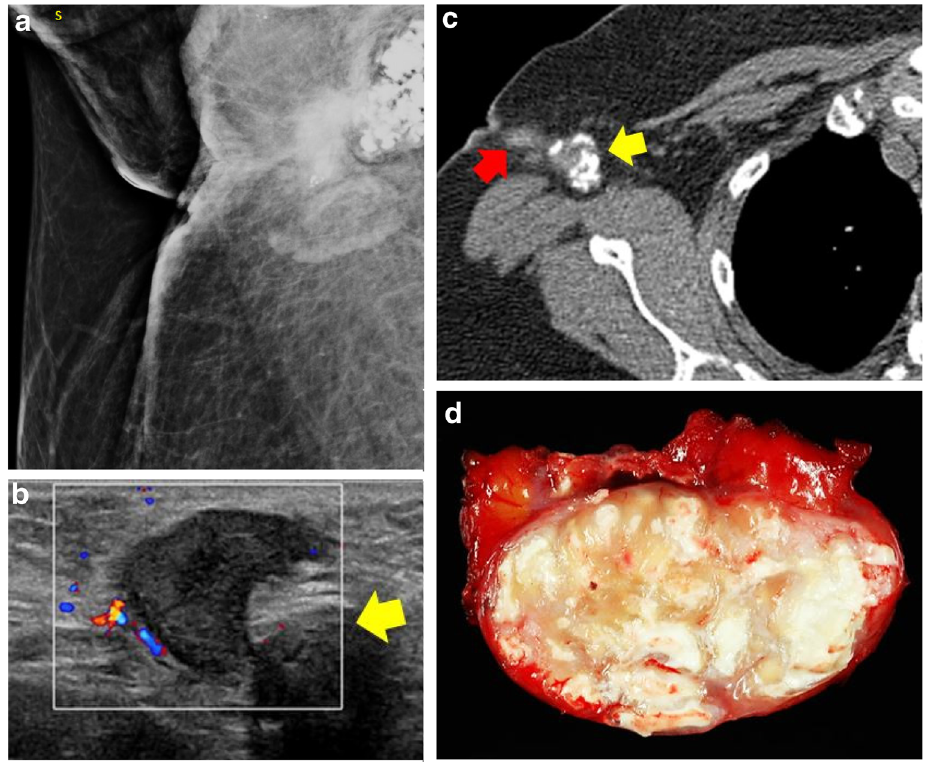
Fig. 10 Granulomatous lymphadenitis. A 44-year-old woman had a tender lump in the right axillary region with recur- rent draining sinuses. a Mammography showed a pre- dominantly calcified right axillary mass with irregular mass and as- sociated skin thickening. b Ultrasound showed multiple hypoechoic round and irregular masses in right axilla, some with calcifications ( yellow arrow ). c CT showed the calcified right ax- illary lymph node ( yellow arrow ) and sinus tract ( red arrow ). d Gross pathological specimen showed organising abscess with acute inflammation and fat ne- crosis. Special stains for bacteria, fungi and mycobacteria were